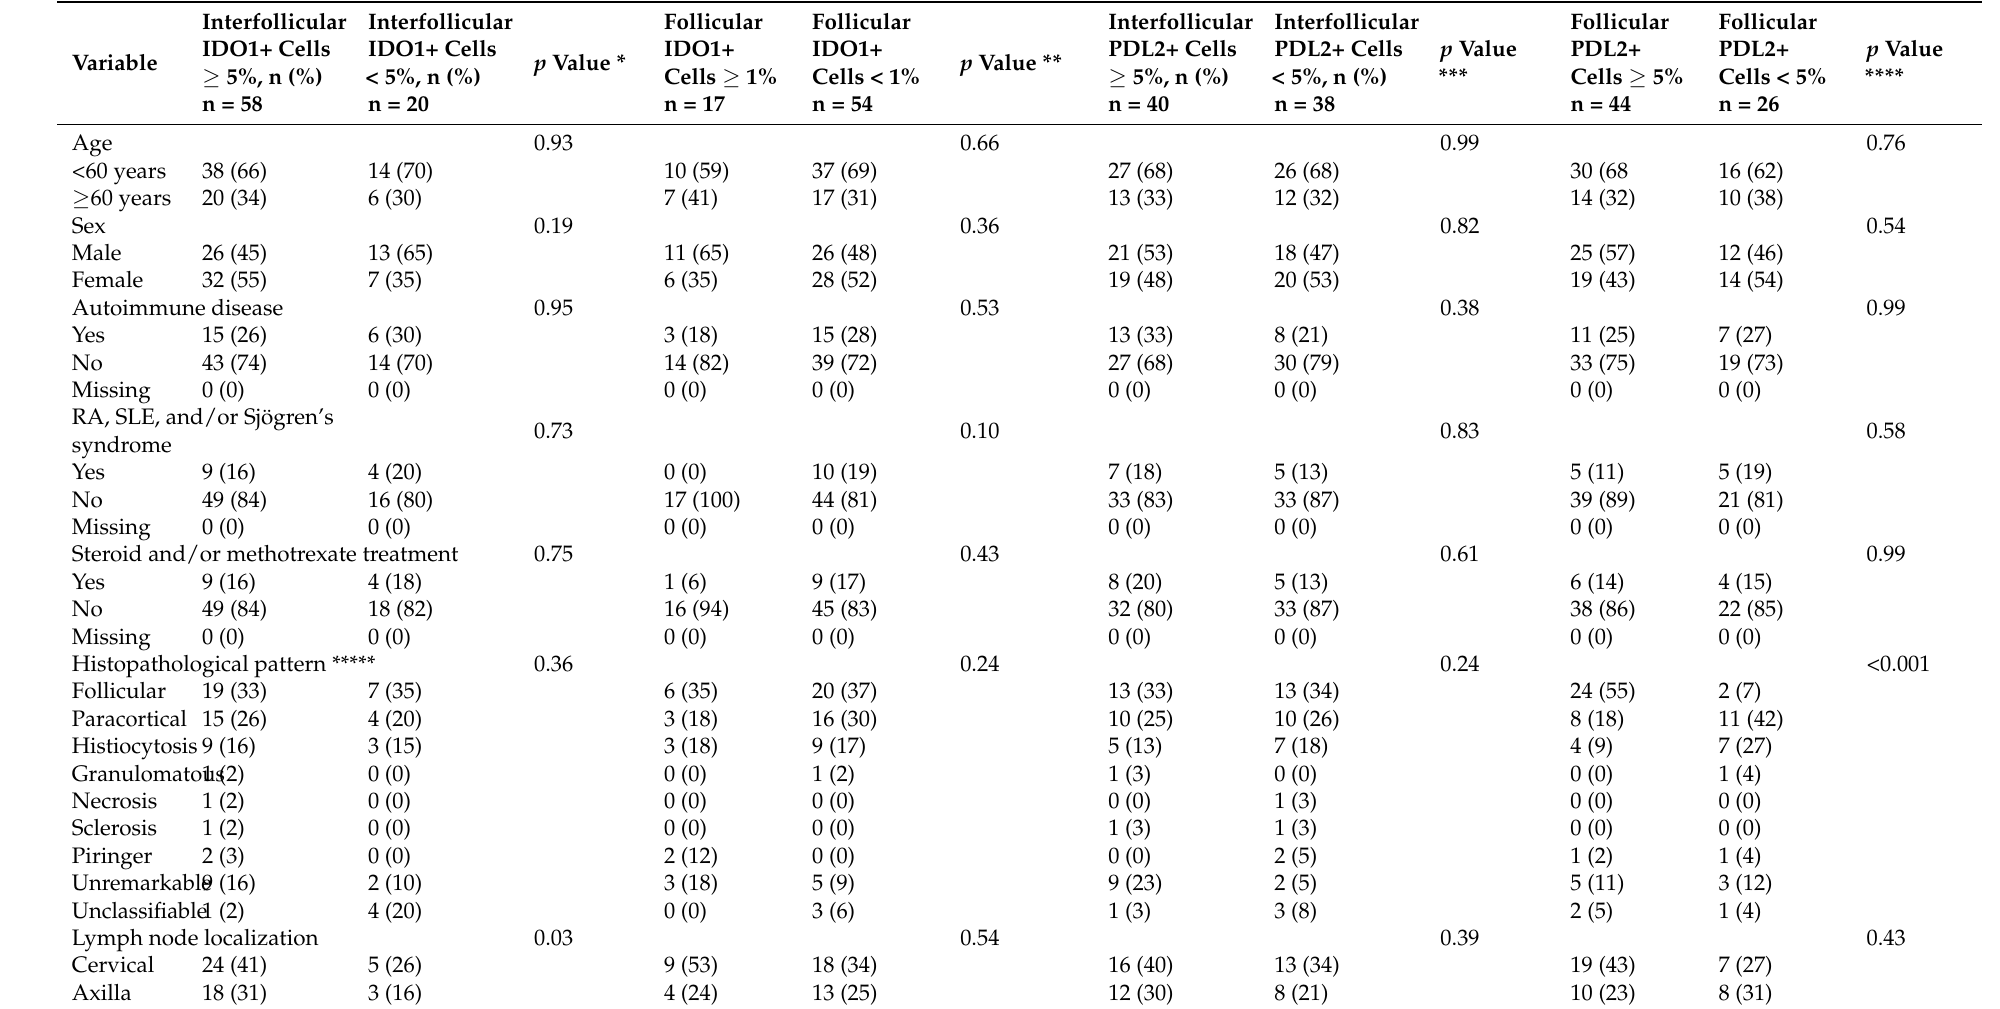
Table 1. Clinicopathological characteristics described according to median proportions of IDO1+ and PD-L2+